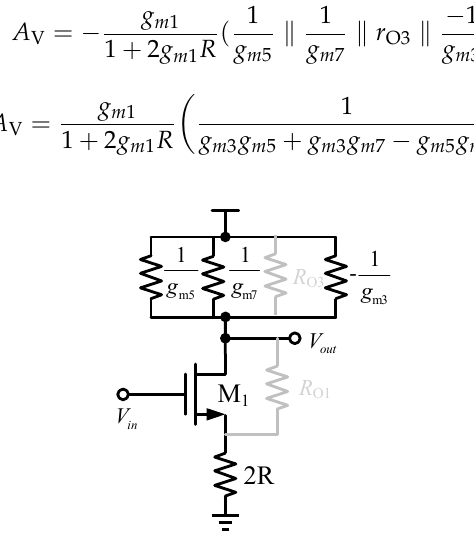
Figure 2. The equivalent half-circuit.